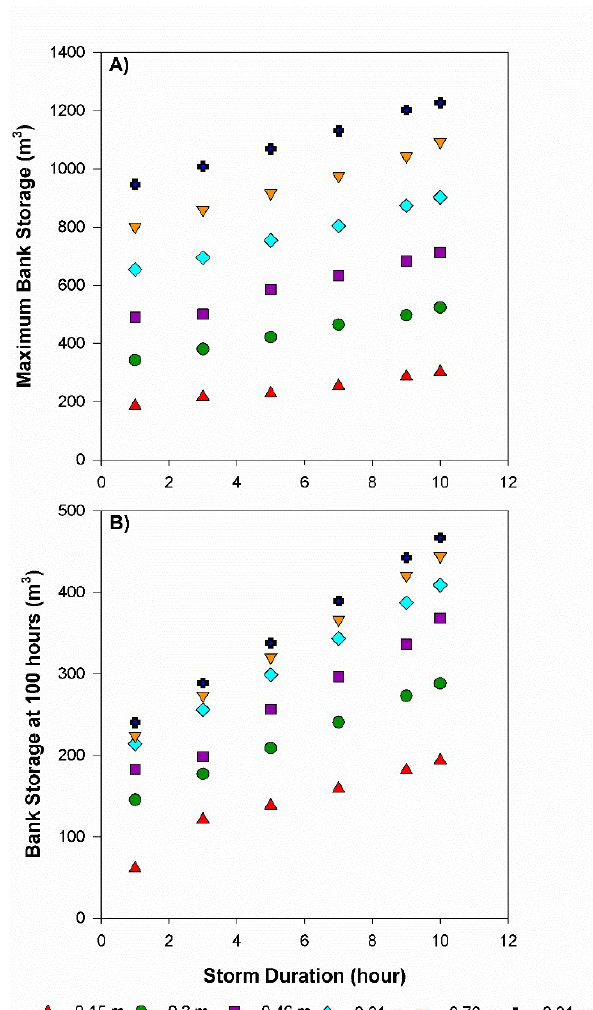
Figure 8. ( A ) Positive relationship between maximum bank storage and storm duration from all 36 numerical model simulations. ( B ) Positive relationship between storage remaining at 100 h and storm duration from all 36 numerical model simulations.